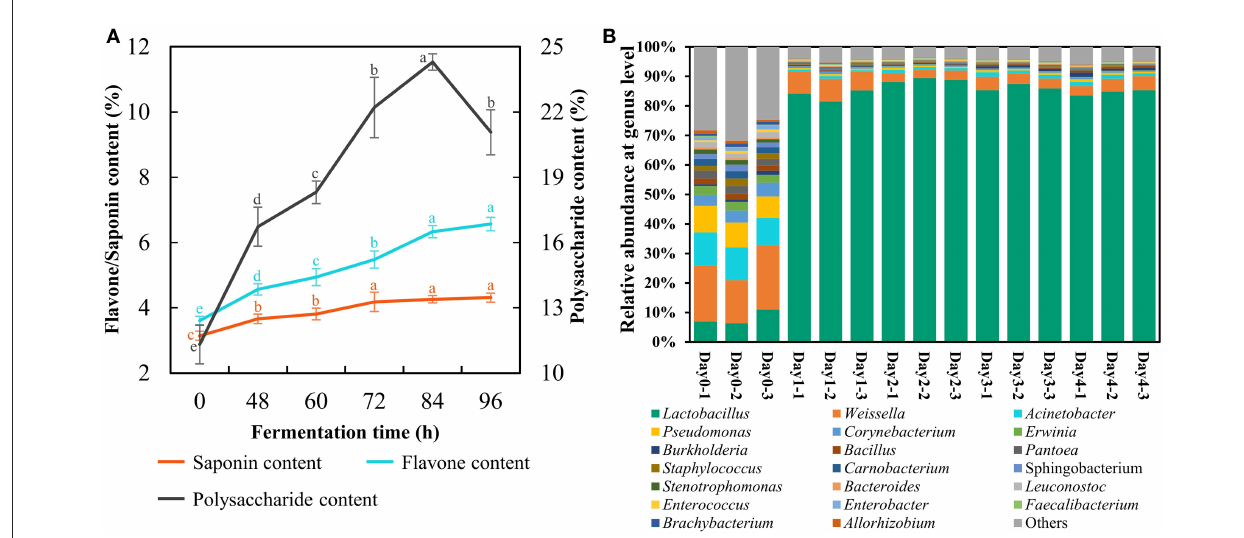
FIGURE3 Changes of bioactive compounds (A) and bacterial community (B) in fermented astragalus at plant scale (one-way ANOVA was performed to evaluate the difference). The same letter showed no significant difference between the chosen groups, while the different letters revealed that significant difference existed between the chosen groups.